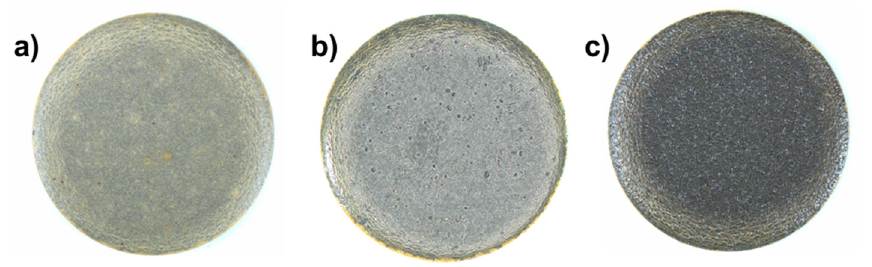
Figure 11. Optical microscopy images of punched 6mm pins: ( a ) PEK + PTFE coating , ( b ) PEEK + PTFE coating , and ( c ) PEKK + PTFE coating .